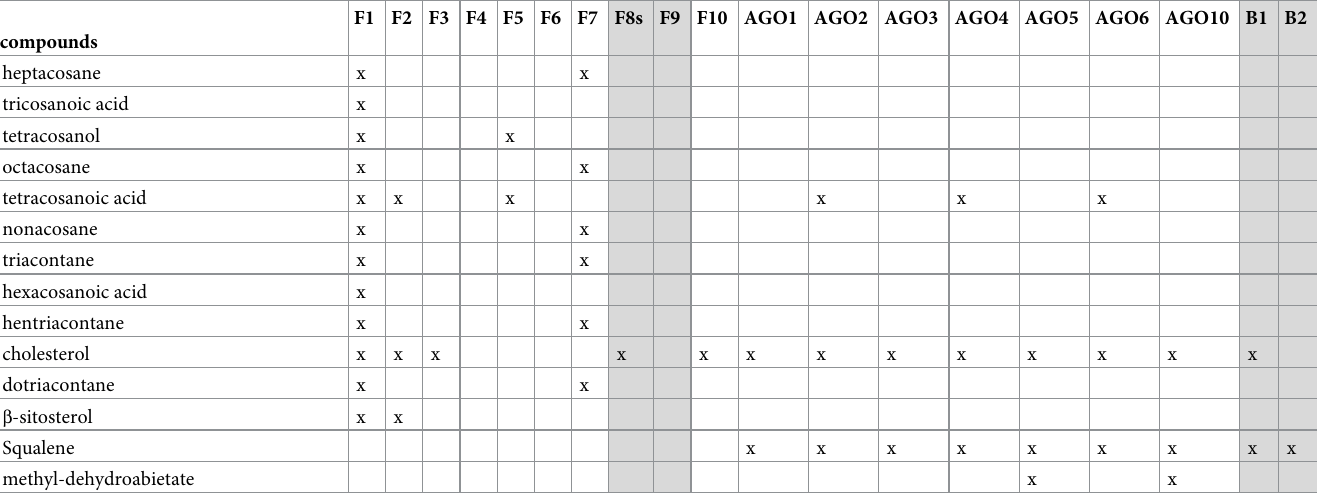
Lignoceric acid (the linear monocarboxylic acid with 24 carbon atoms) was present in sam- ples F1, F2, and F5 only (chromatograms in Fig 7 and Figs L and F in S2 File), and hexacosa- noic acid (C26:0), also called cerotic acid, was identified in sample F1. The most abundant acids were palmitic (hexadecanoic acid, C16:0) and stearic acid (octadecanoic acid, C18:0). In all the samples, long chain alcohols (12–20 carbon atoms) were identified in different relative amounts. The presence of long-chain monocarboxylic fatty acids along with long chain alco- hols and alkanes in significant amount with respect to the blank indicated the presence of plant material, including glycerolipids and waxes [102].